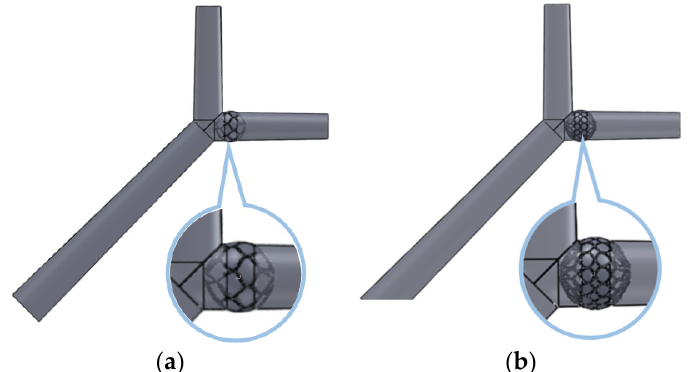
Figure 10. Spherical occlusion device placed in the right hepatic artery near the branch with ( a ) lower and ( b ) higher occlusion densities.